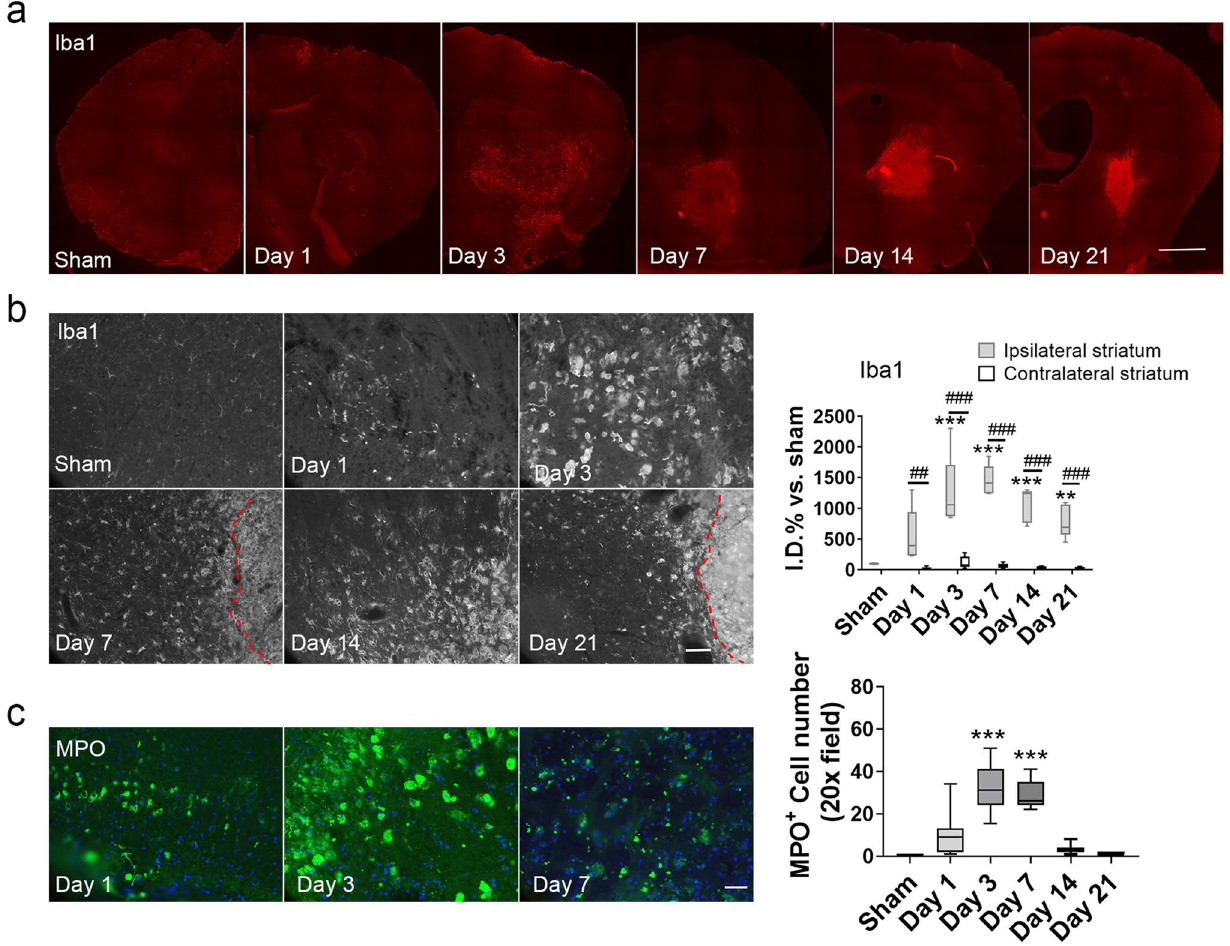
Figure 5. Iba1- and myeloperoxidase (MPO)-positive cells are heightened in ipsilateral striatum after ICH. ( a ) Representative images show ipsilateral brain sections stained for Iba1 (red) under low magnification at each time point after ICH. Scale bar: 500 µm. ( b ) Representative images (left) and quantification (right) of Iba1 (gray) expression in striatum at different time points after ICH. The outlined area indicates the hematoma core. Scale bar: 50 µm. n = 5/group. ** p < 0.01, *** p < 0.001 versus sham group; ## p < 0.01, ### p < 0.001 versus contralateral side. Two-way ANOVA with Bonferroni post hoc test. ( c ) Representative images (left) and quantification (right) of MPO-positive cells (green) in the perihematomal region after ICH. Scale bar: 50 µm, blue: DAPI. n = 5/group. *** p < 0.01 versus sham group. One-way ANOVA with Bonferroni post hoc